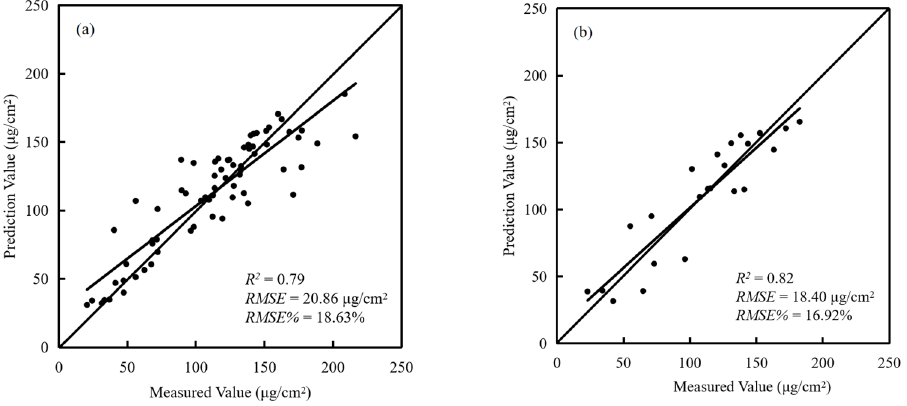
Figure 7. ML-HM model results. ( a ) Calibration; ( b ) Validation.